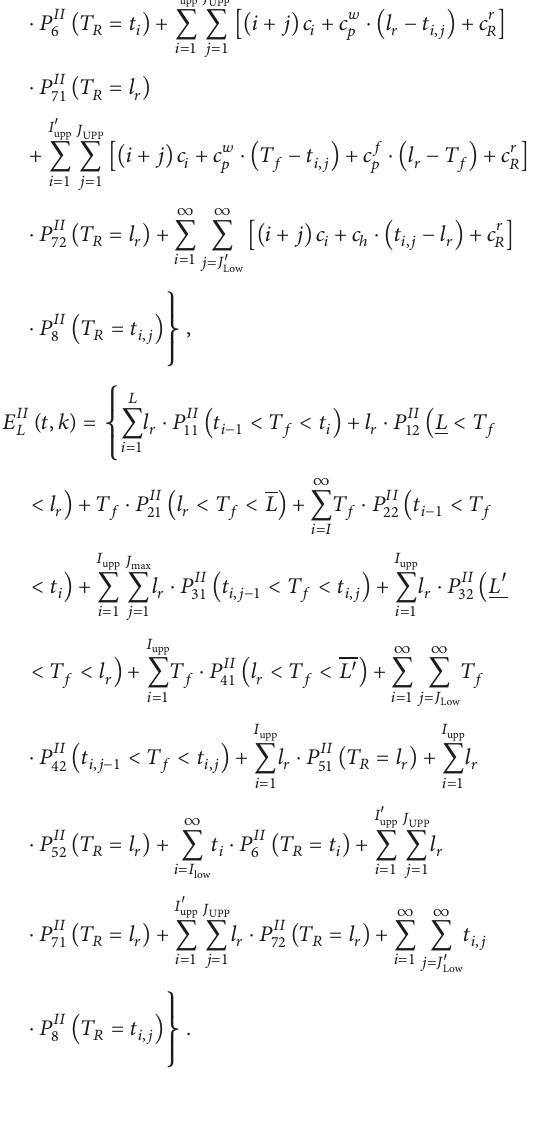
stages are 𝐸(𝑋 1 ) = 52.2972 days, 𝐸(𝑋 2 ) = 60.6945 days, and 𝐸(𝑋 3 ) = 24.1147 days, respectively. The PDF of the illustration based on the preset parameters in Table